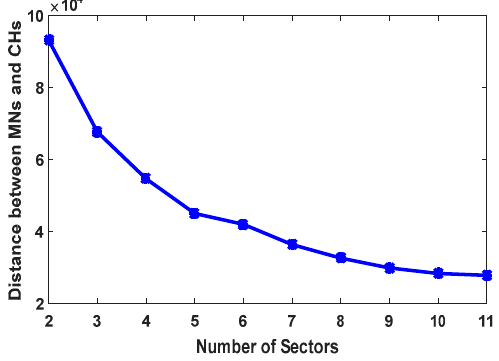
Figure 4. The influence of the angle of sectors on.